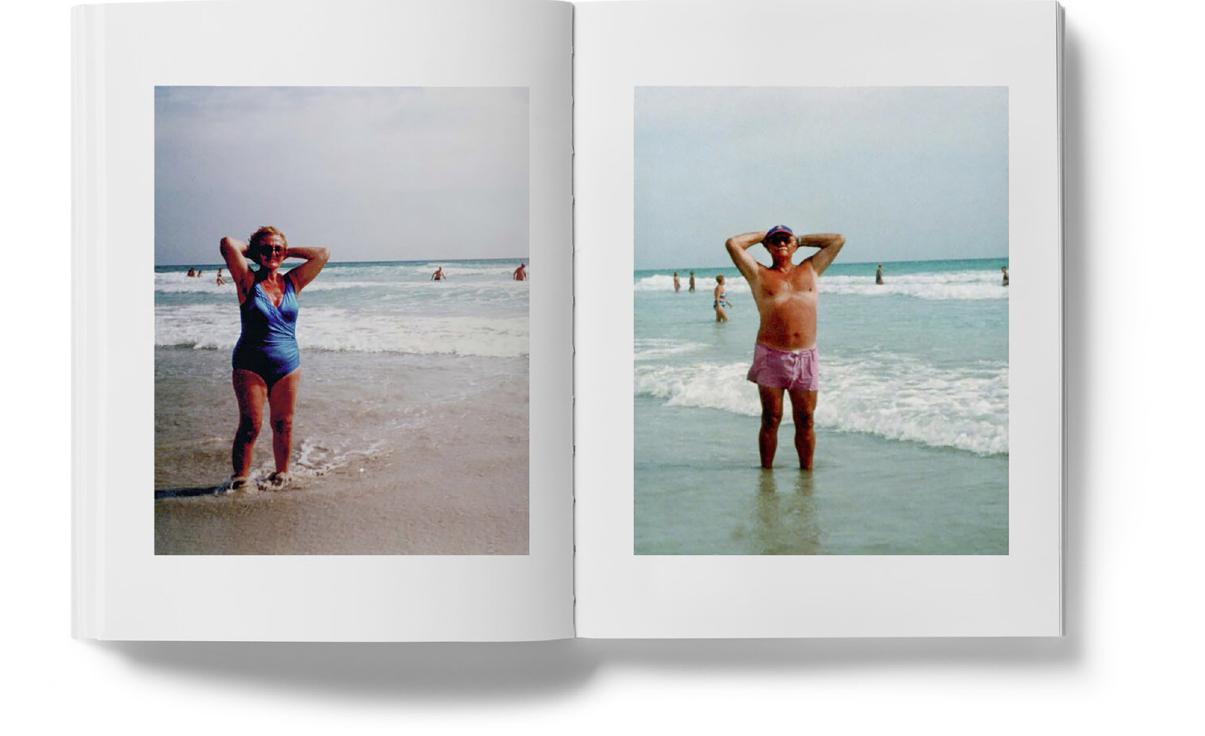
Fig. 5 Erik Kessels, In Almost Every Picture 17 , 2021. Courtesy of Erik Kessels ©